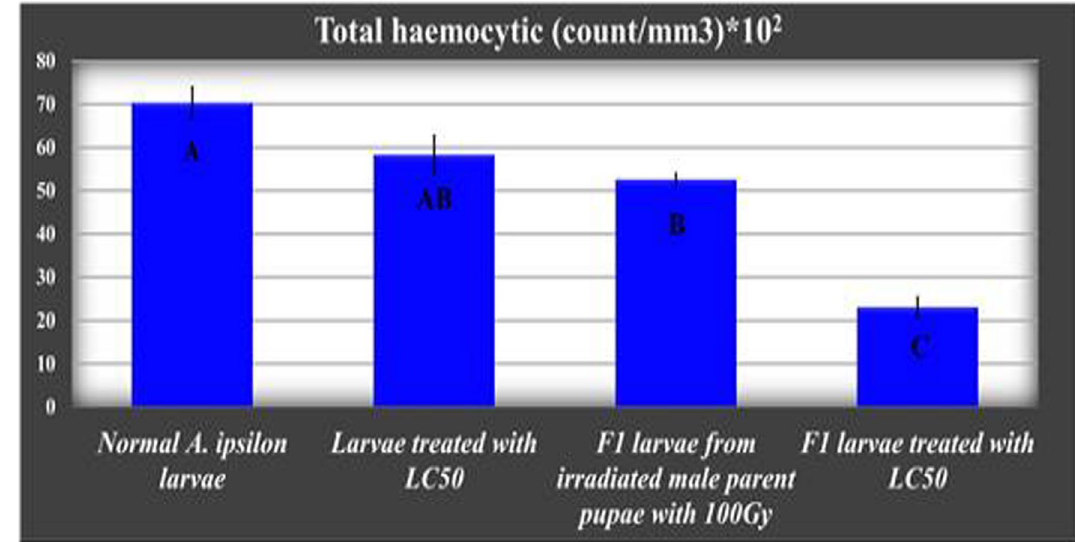
Fig. 4 Total haemocytic (count/mm 3 Metarhizium anisopliae . Values represent the mean Pairwise Comparisons). LC 50 of normal (unirradiated) and F1 larvae 20.49